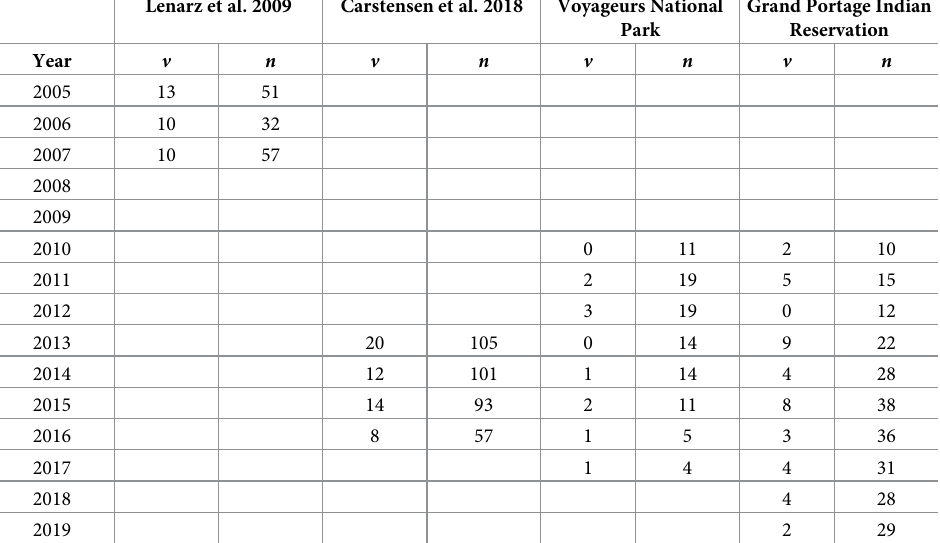
Table 2. Number of moose that died and were at-risk by year and study. Telemetry data from four different studies of annual mortality ( v ) and associated at-risk counts ( n ) for yearling and adult moose in northeastern Minnesota, USA,